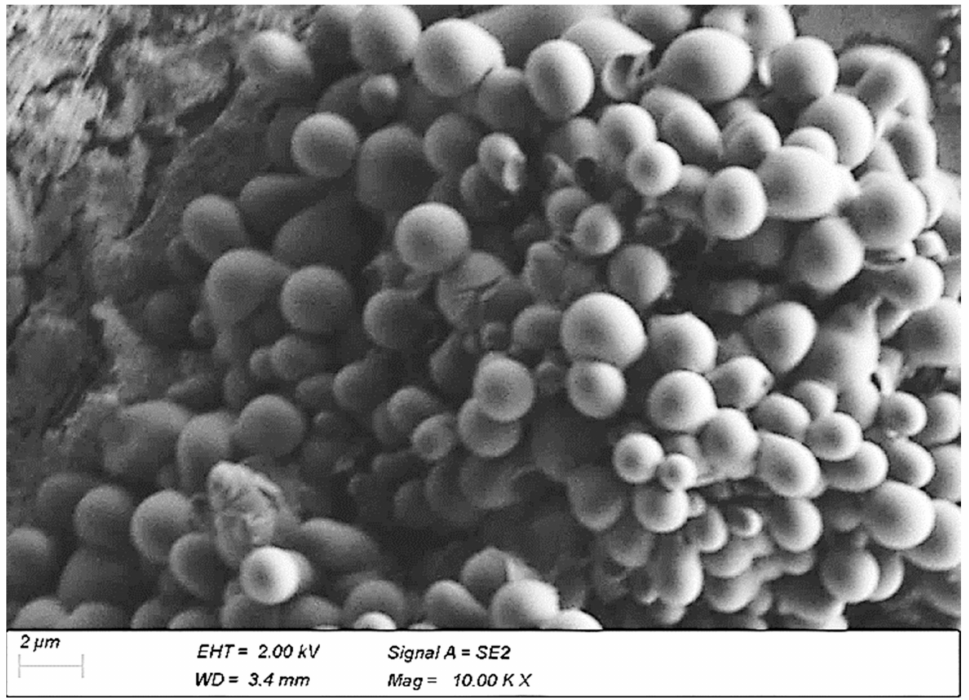
Figure 11. SEM micrograph prof the HCT-loaded SMS-PCL nanoparticles, confirming their poly- meric